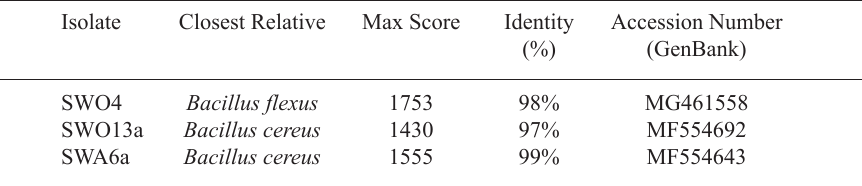
Table 2. The Closest Relative, Max Score and Identity % obtained from the BLASTn analysis of the three isolates. The GenBank accession numbers of the strains are also mentioned Isolate Closest Relative